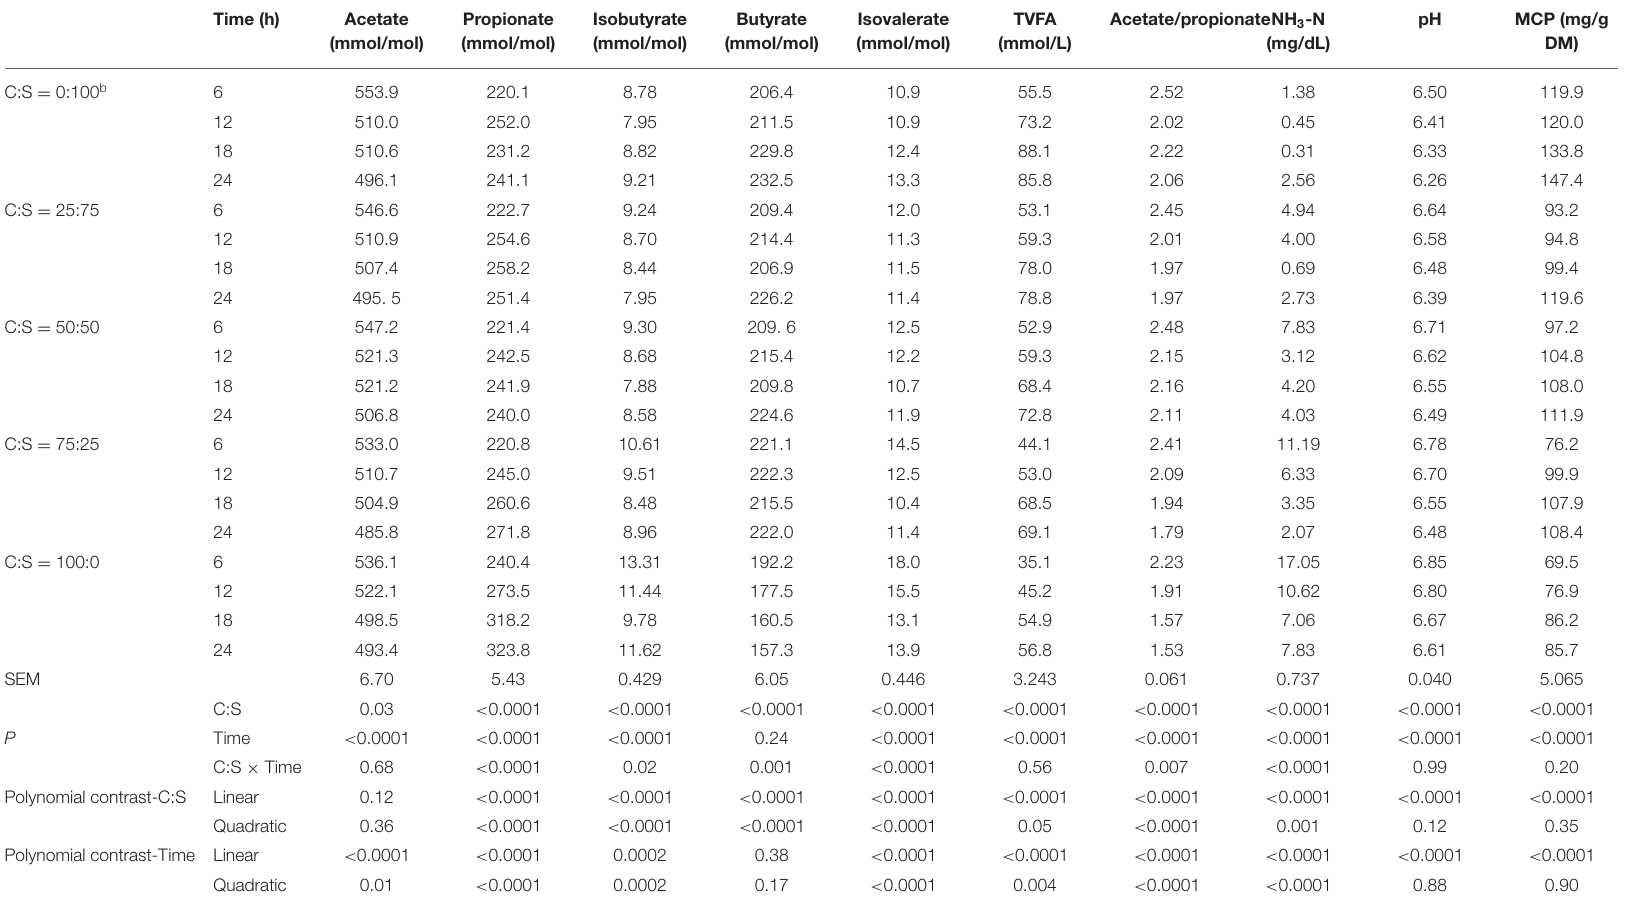
TABLE 4 | Effect of different ratios of cellulose and starch (C:S) on ruminal fermentation parameters and MCP a concentration during 24 h of incubation in vitro .